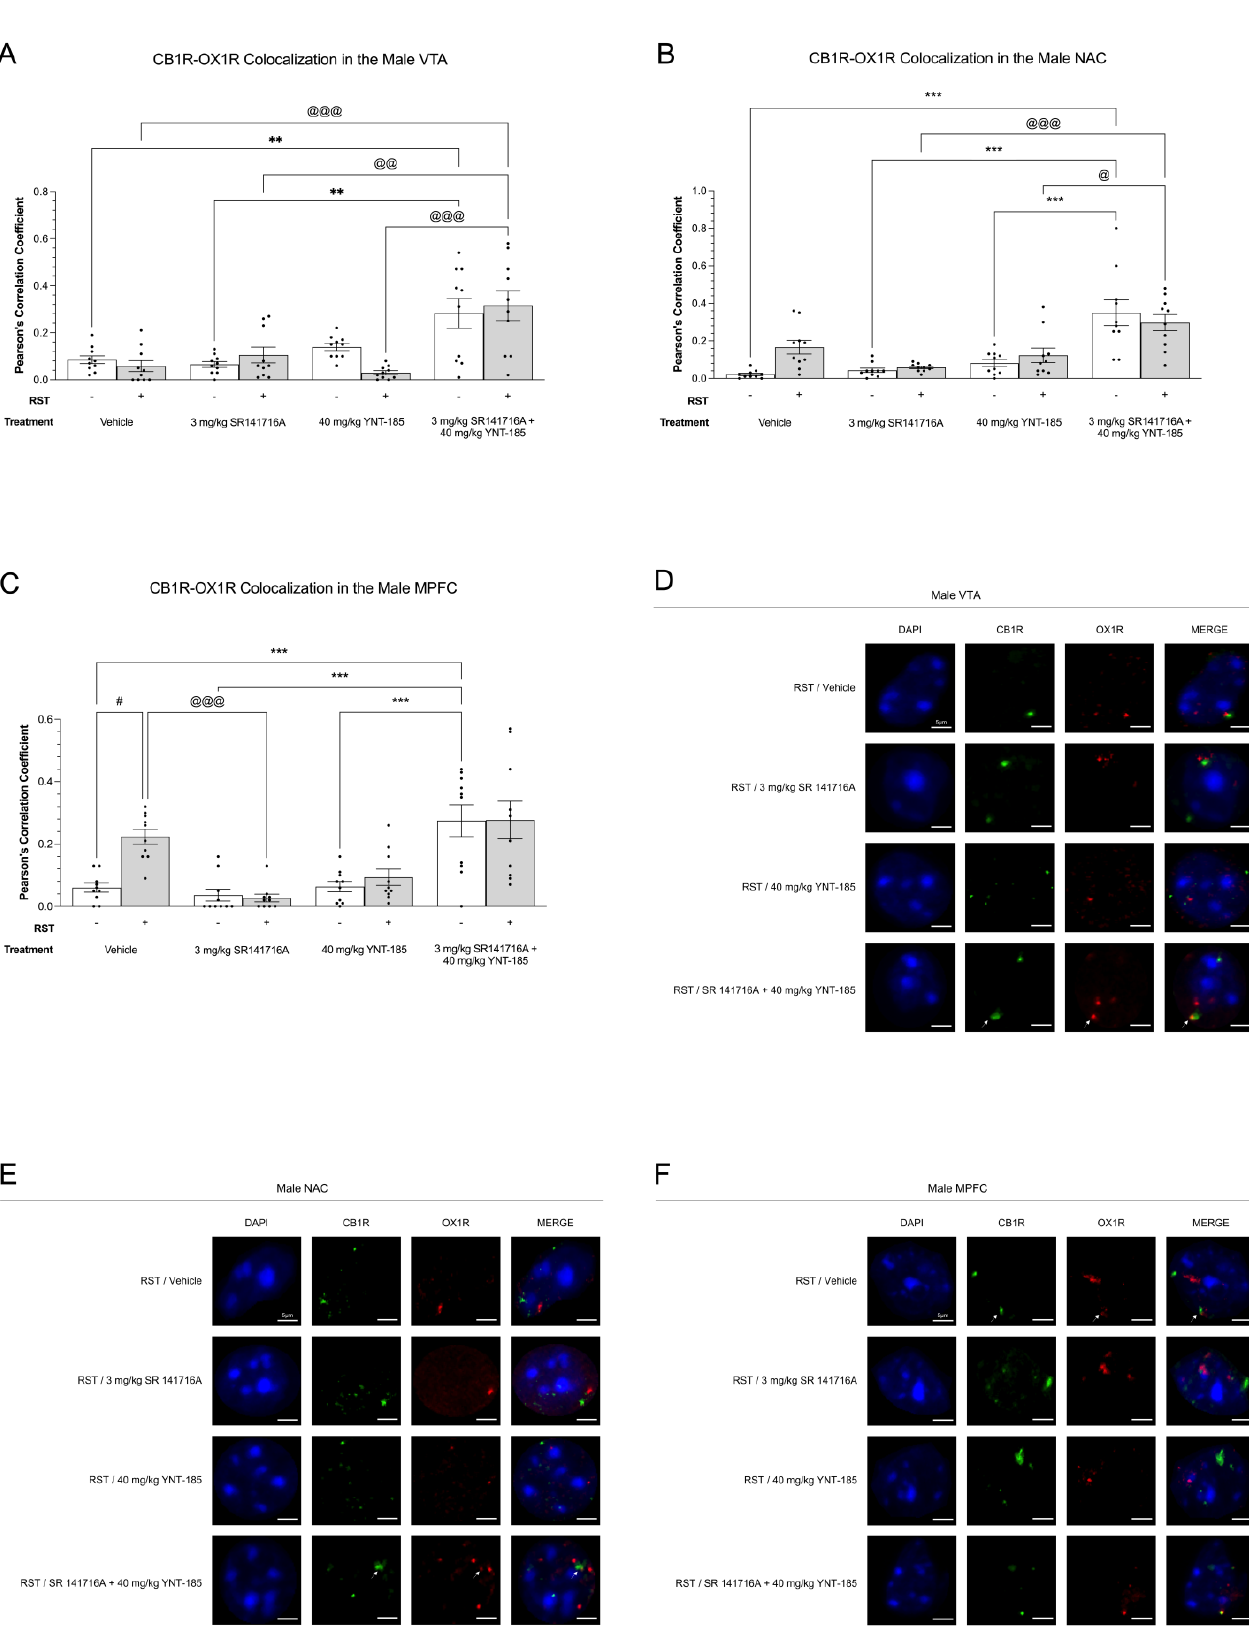
Figure 5. Colocalization between CB1R and OX1R in male mesocorticolimbic brain regions following prolonged restraint stress and drug treatments. ( A – C ), CB1R-OX1R colocalization in the VTA ( A , D ), NAC ( B , E ), and MPFC ( C , F ) of 200 µL vehicle, 3 mg/kg SR141716A, 40 mg/kg YNT-185, and